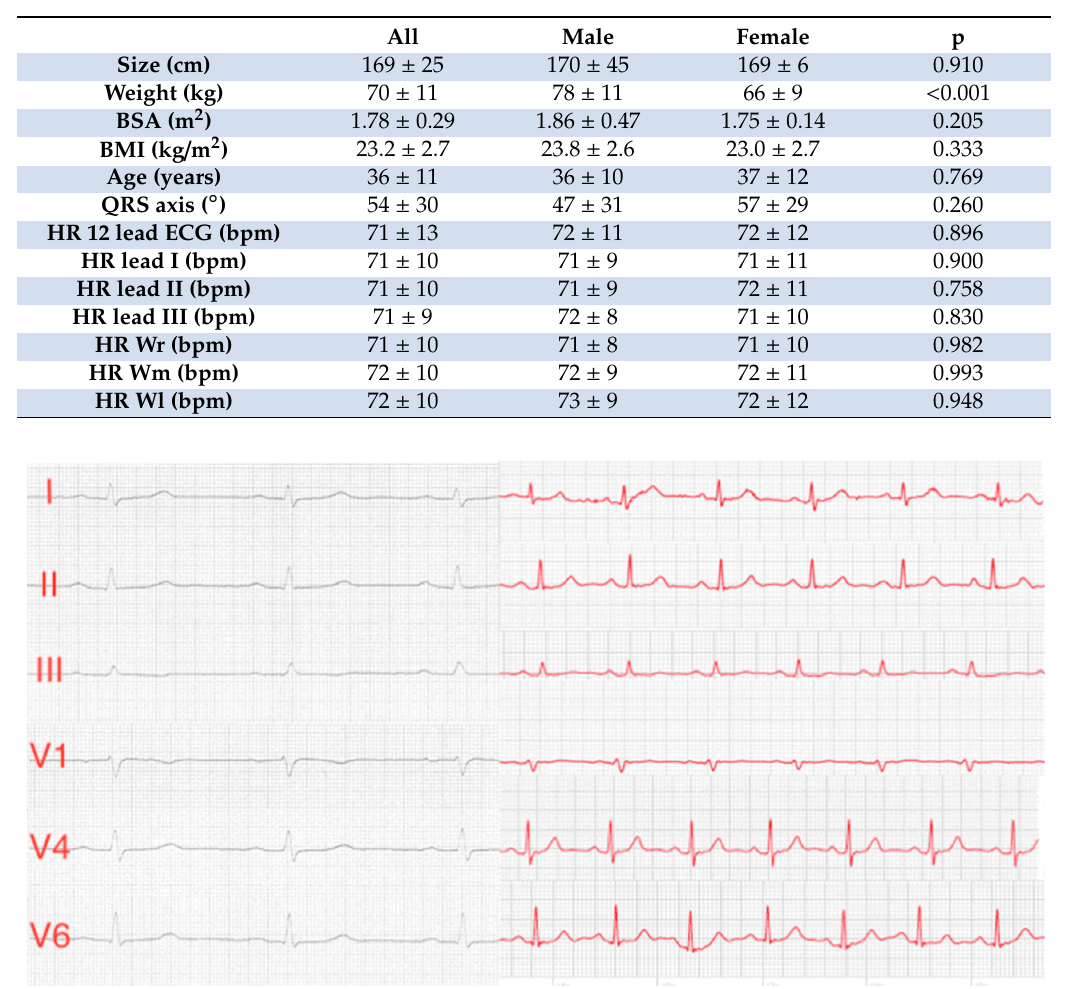
Figure 2. Comparison of typical standard Einthoven I–III leads and Wilson chest leads V1, V4 and V6 from standard ECG (black ECG curves) and Apple Watch ECGs (red ECG curves). Table 2. Correlations between correct ECG assumption and study population characteristics